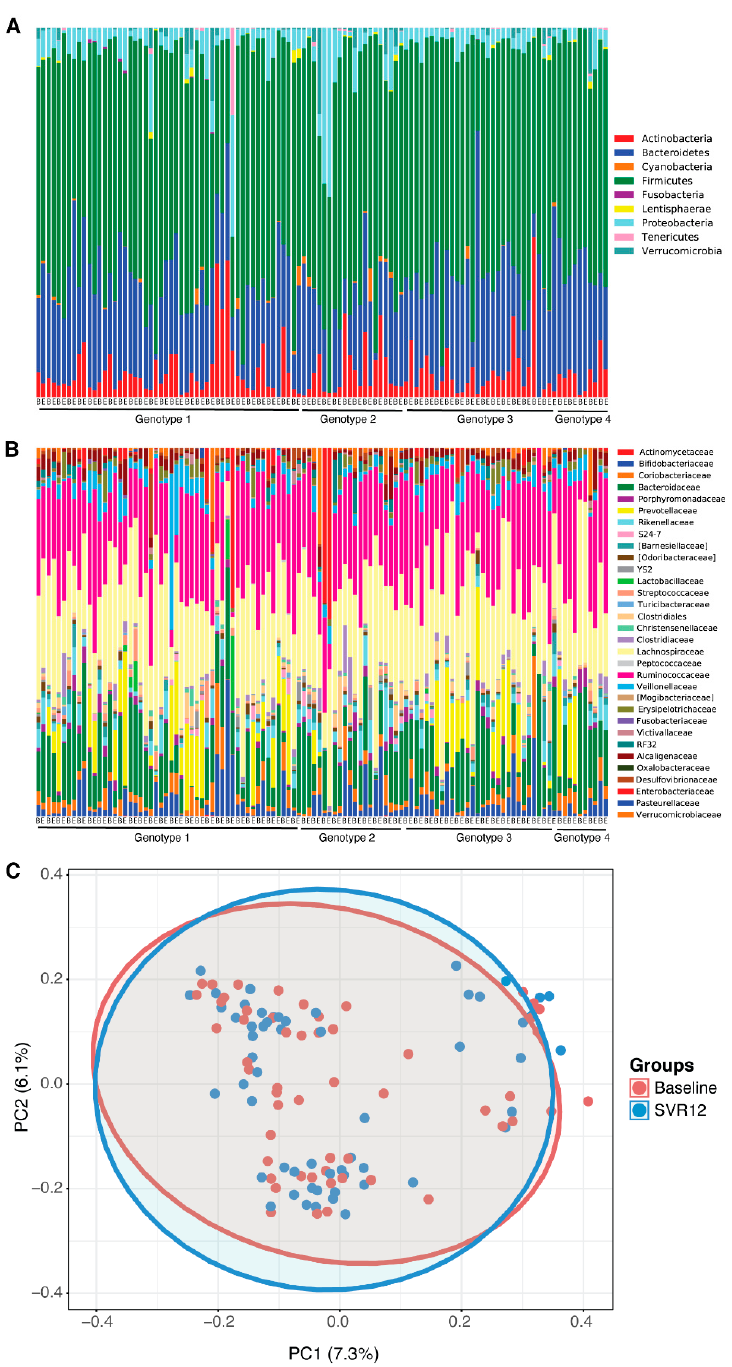
Figure 1. Microbial differences before treatment (baseline) vs. SVR12 groups. Taxonomy profile of patients at baseline and 12 weeks after the end of the treatment are shown ( A ) at phylum level and ( B ) at family level. ( C ) Microbial clustering is shown based on generalized UniFrac metrics using fecal DNA samples at baseline and SVR12. Non-parametric analysis of variance (Adonis) was used to test significant differences between groups on the PCoA plot, with a result of p > 0.05. The ellipses represent a 95% CI surrounding each disease group. B = baseline; E = end of treatment; PC = principal component; PCoA = principal coordinate analysis; SVR12 = sustained virologic response 12 weeks after the end of the treatment.